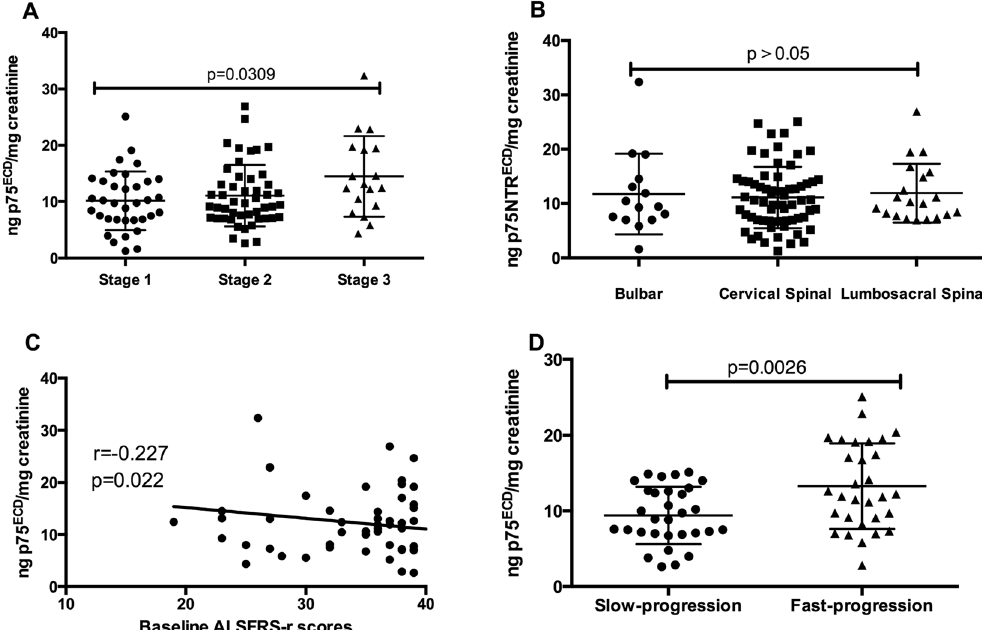
Figure 4. Urine p75 ECD levels and ALS-severity and progression. ( A ) There was significant difference among three clinical stages; ( B ) There were no differences in urine p75 ECD concentrations among ALS patients with different onset regions; ( C ) There was negative correlation between baseline p75 ECD and ALSFRS-r scores in ALS patients; ( D ) Significantly higher urine p75 ECD concentrations were detected in the fast-progression group than in the slow-progression